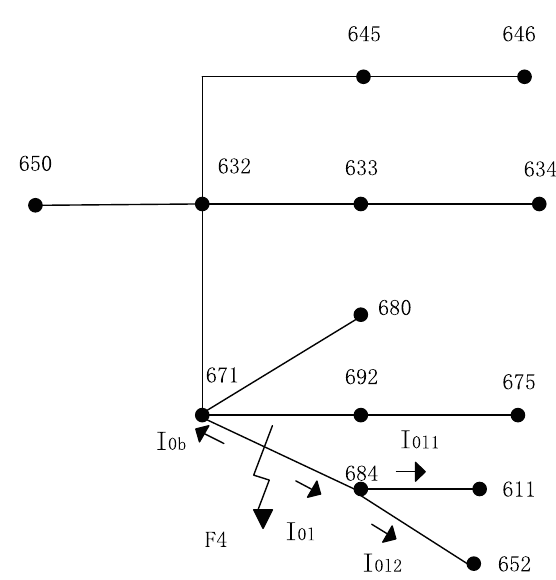
Fig. 8 Influence of branch zero sequence capacitance